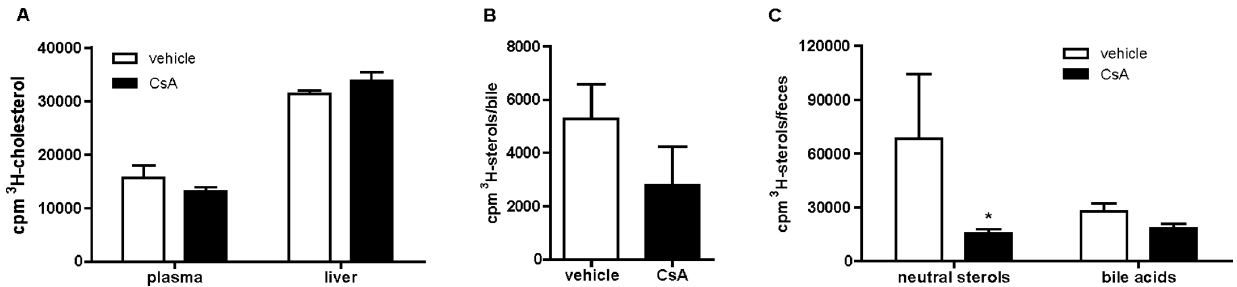
Figure 2. CsA treatment effect on macrophage RCT from MPM in vivo. C57BL/6 mice were treated with CsA as described in Figure 1. On day 13 of pharmacological treatment, animals were intraperitoneally injected with [ 3 H]-cholesterol loaded MPM. After 24 h, mice were sacrificed and macrophage-derived [ 3 H]-cholesterol distribution was quantified in plasma, liver and feces as described in the Methods section. A: [ 3 H]-cholesterol in plasma and liver; B: [ 3 H]-sterols in the bile; C: [ 3 H]-neutral sterols and [ 3 H]-bile acids in the feces. Results are expressed as mean 6 SD (n=7 mice per group). *p , 0.05 vs. vehicle.